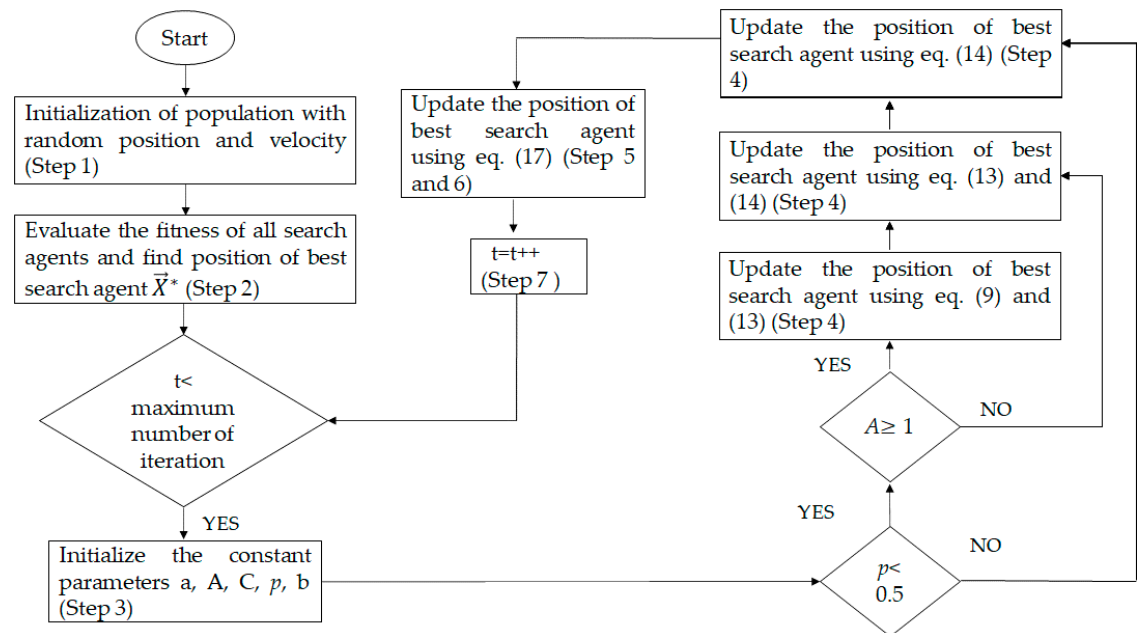
Figure 2. Flowchart of proposed hybrid version of whale optimization and particle swarm optimization WOAPSO algo- rithm.